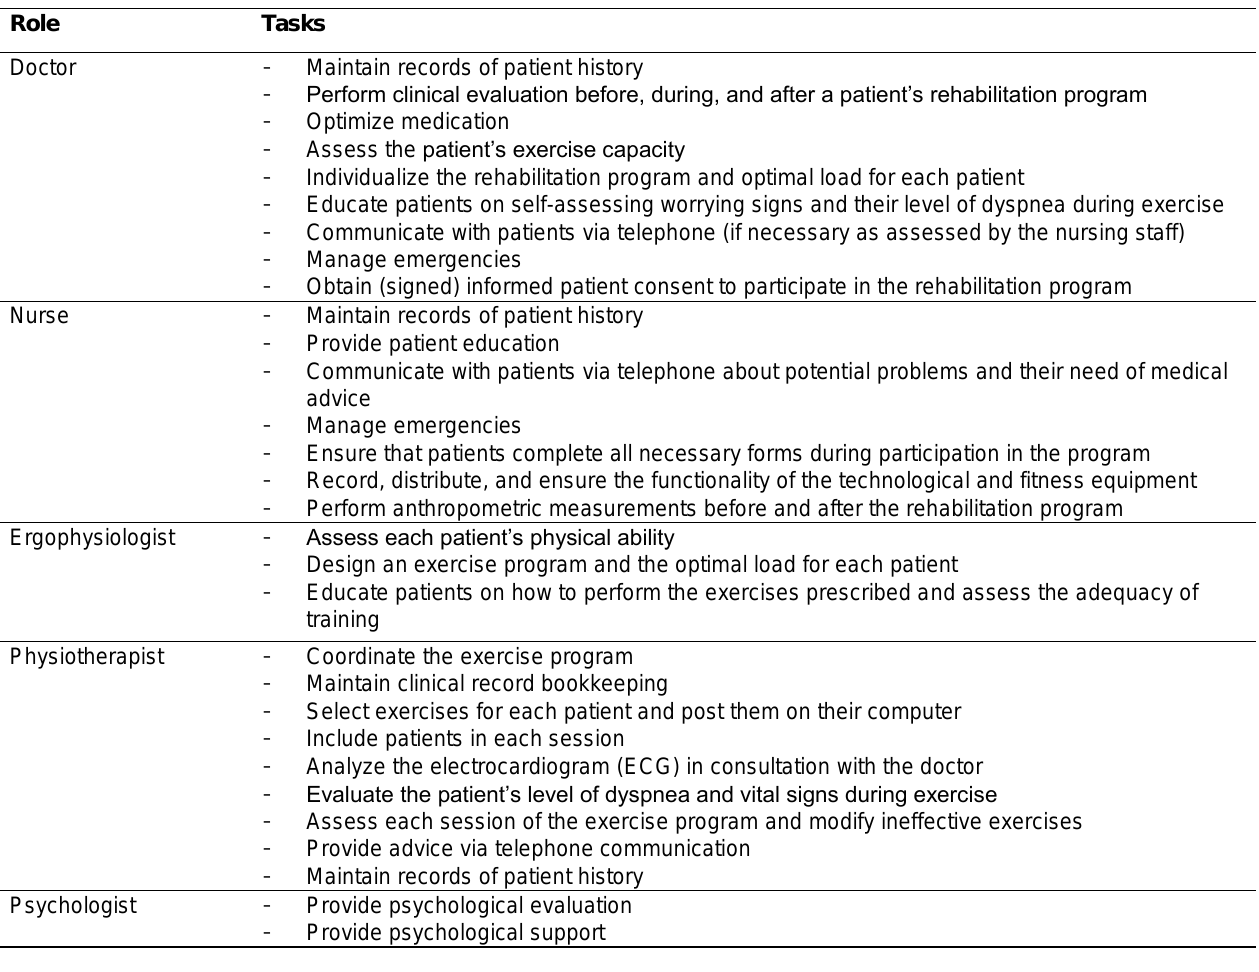
Table 1. Roles and Tasks of the Telerehabilitation Staff Role